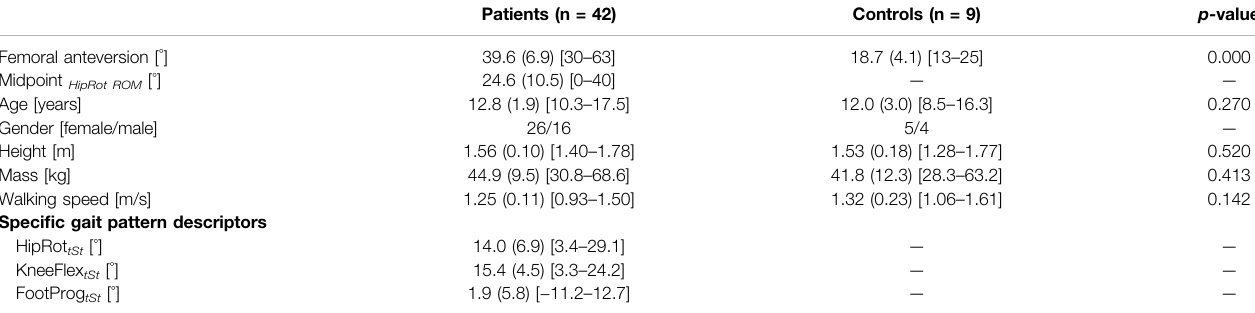
Midpoint HipRotROM ,Midpointofpassivehiprotationrangeofmotion(positivevalueindicateinternalrotation);HipRot tSt ,meanhiprotationinterminalstance;KneeFlex tSt ,meanknee fl exion in terminal stance; FootProg tSt , mean foot progression angle in terminal